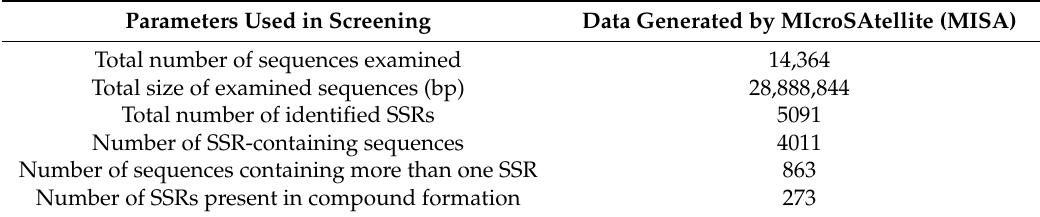
Table 1. Summary of RNA-Sequence for SSRs in Chinese hawthorn ( C. pinnatifida